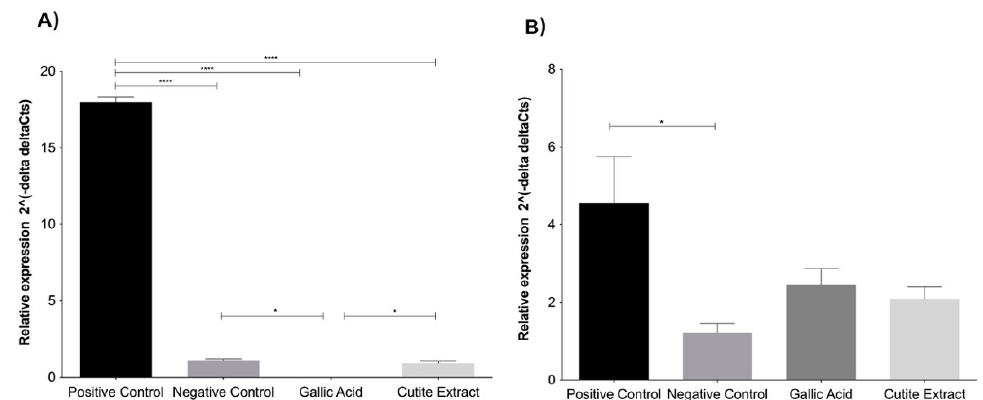
Figure 3. Levels of expression of MITF ( A ) and Tyrosinase ( B ) genes treated with gallic acid and extract. Each bar represents an average of 3 determinations ± SD. * p < 0.05; **** p < 0.0001. Tyrosinase gene expression was suppressed after treatment with GA (2.457 ±